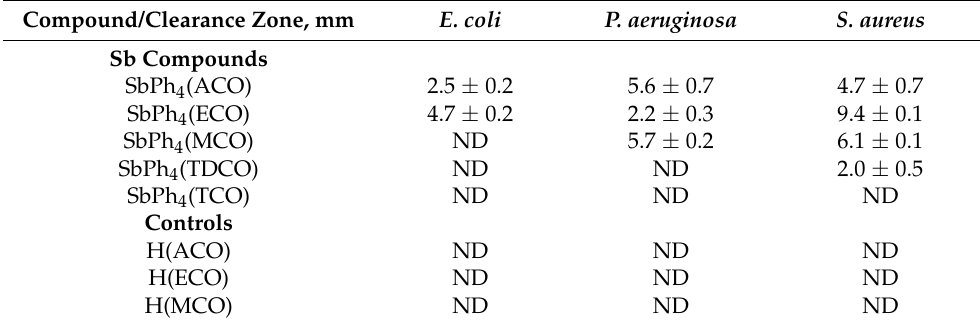
Table 1. Antibacterial effect of new tetraphenyl-antimony(V) cyanoximates determined by disc- diffusion assay. The zones of clearance (mm) surrounding the discs are reported as the averages from three samples ± SEM. ND, no clearance zone